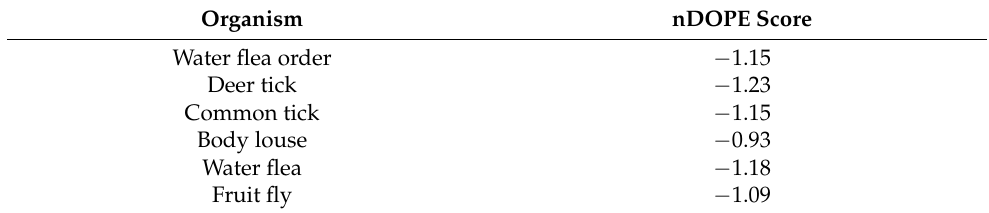
Table 5. Normalised DOPE scores of SARS-CoV-2 N501Y S-protein: ectoparasite ACE complexes. Organism nDOPE Score Water flea order − 1.15 Deer tick